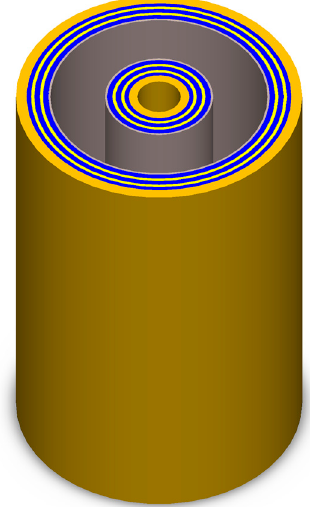
Figure 2. 1D cylinder blanket model.